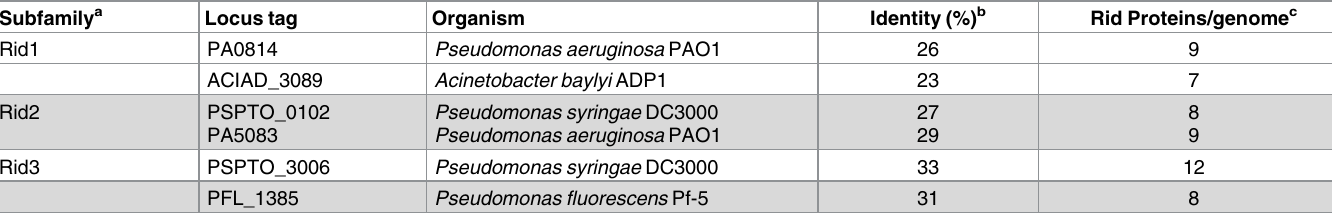
Table 3. Rid subfamily representatives and identity to S . enterica RidA.